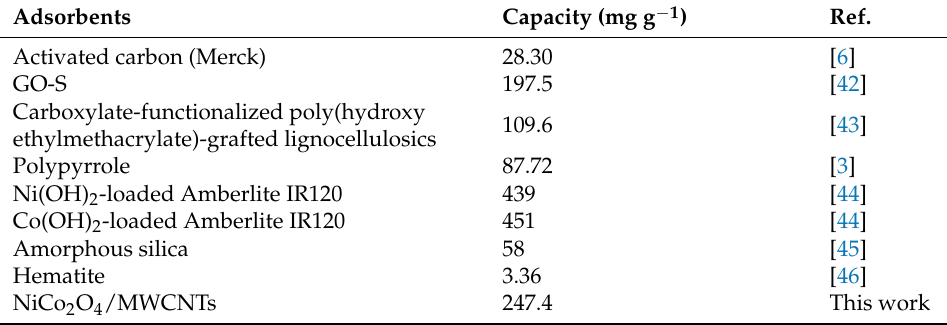
Table 3. Comparison of uranium adsorption performance of NiCo 2 O 4 /MWCNT and other